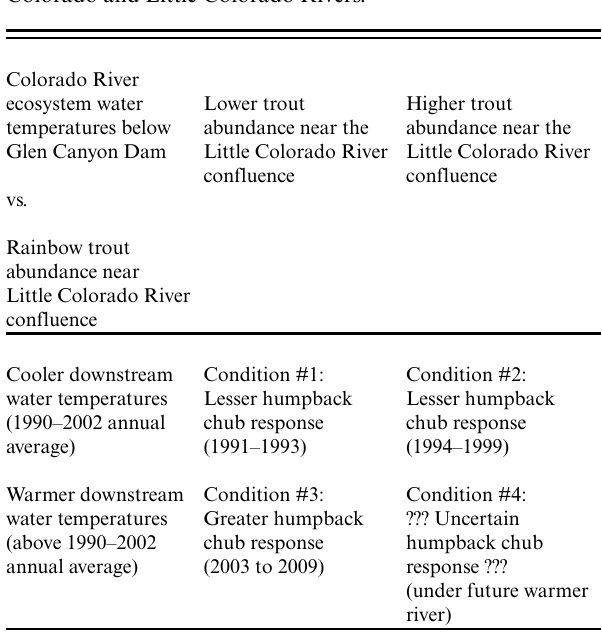
Table 2. Matrix showing the varied conditions under which humpback chub of the Colorado River ecosystem in Grand Canyon National Park have been monitored (1991–2008), and their general response to varied conditions of water temperature below the dam and to trout abundance near the confluence of the Colorado and Little Colorado